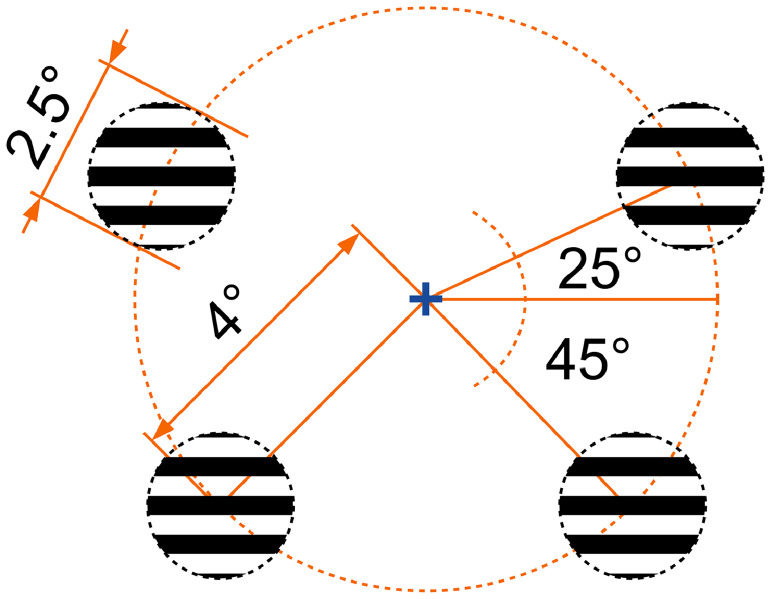
Visual stimulus locations used in the two experiments. The stimuli were presented randomly and one at a time, with rare vertical gratings serving as behavioral targets.